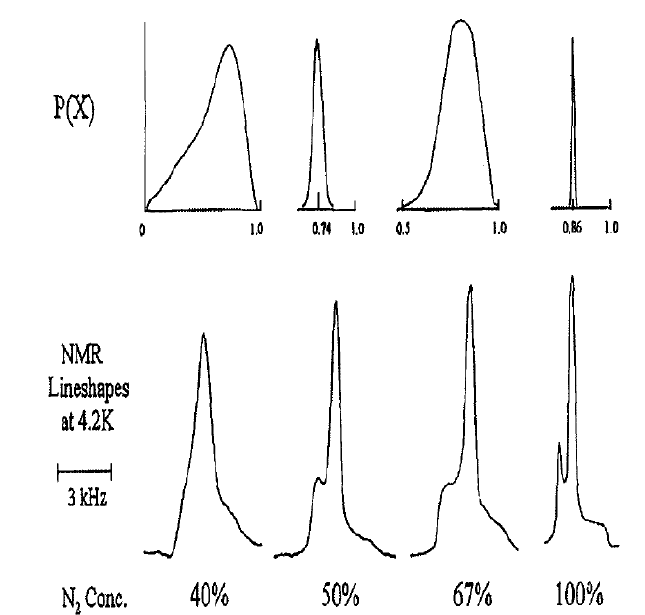
Figure 13. Variation of observed low temperature NMR line shapes with nitrogen concentration in solid N 2 -Ar mixtures, showing inferred distributions of order parameters P ( σ ) . Reproduced with permission from [38]. Copyright Springer Nature,